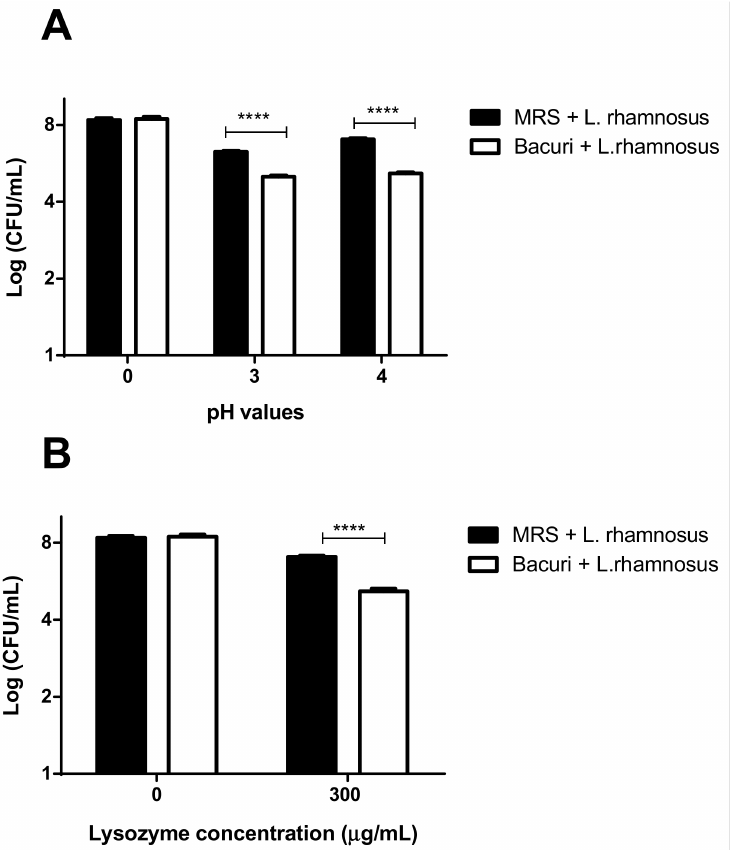
Figure 3. Test of tolerance to simulated conditions of the gastrointestinal tract. ( A ) pH tolerance test. ( B ) Lysozyme tolerance test. MRS + L. rhamnosus = L. rhamnosus ATCC 9595 grown on MRS; bacuri + L. rhamnosus = L. rhamnosus ATCC 9595 grown on bacuri juice. **** p <